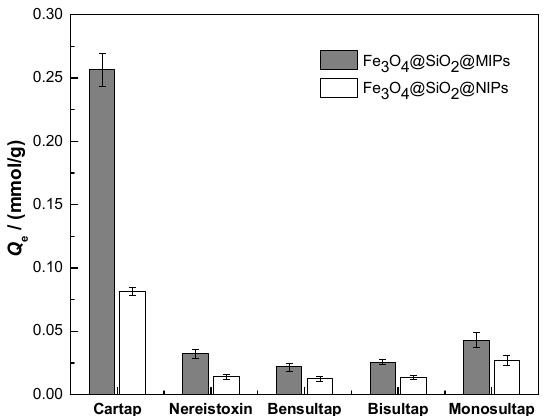
Figure 5. Adsorption capacities of cartap in the presence of its analogues (nereistoxin, bensultap, bisultap, monosultap) in mixture solution with the initial concentrations of 4.0 mmol/L for each one on Fe 3 O 4 @mSiO 2 @MIPs and Fe 3 O 4 @mSiO 2 @NIPs at 298 K.